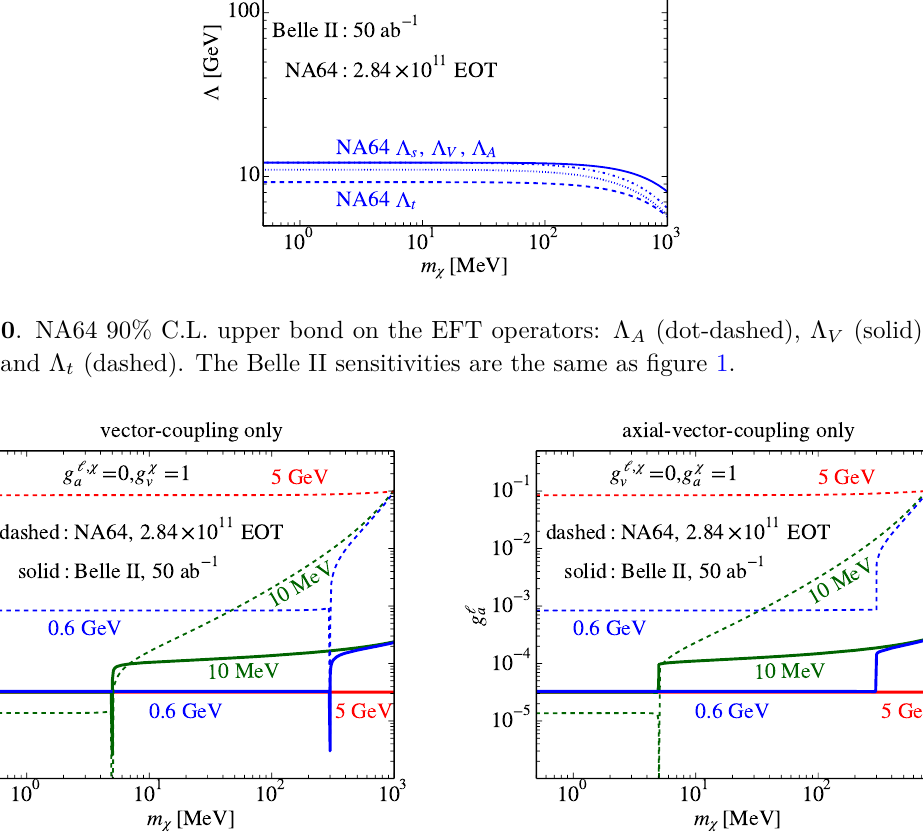
Figure 11 . NA64 90% C.L. upper bond (dashed lines) on the light mediator models with vector couplings (left) and axial-vector couplings (right). The green, blue, and red lines show the con- straints for m = 10 MeV , 0 . 6 GeV , and 5 GeV respectively. The Belle II sensitivities (solid lines) Z 0 are the same as figure 2 and figure